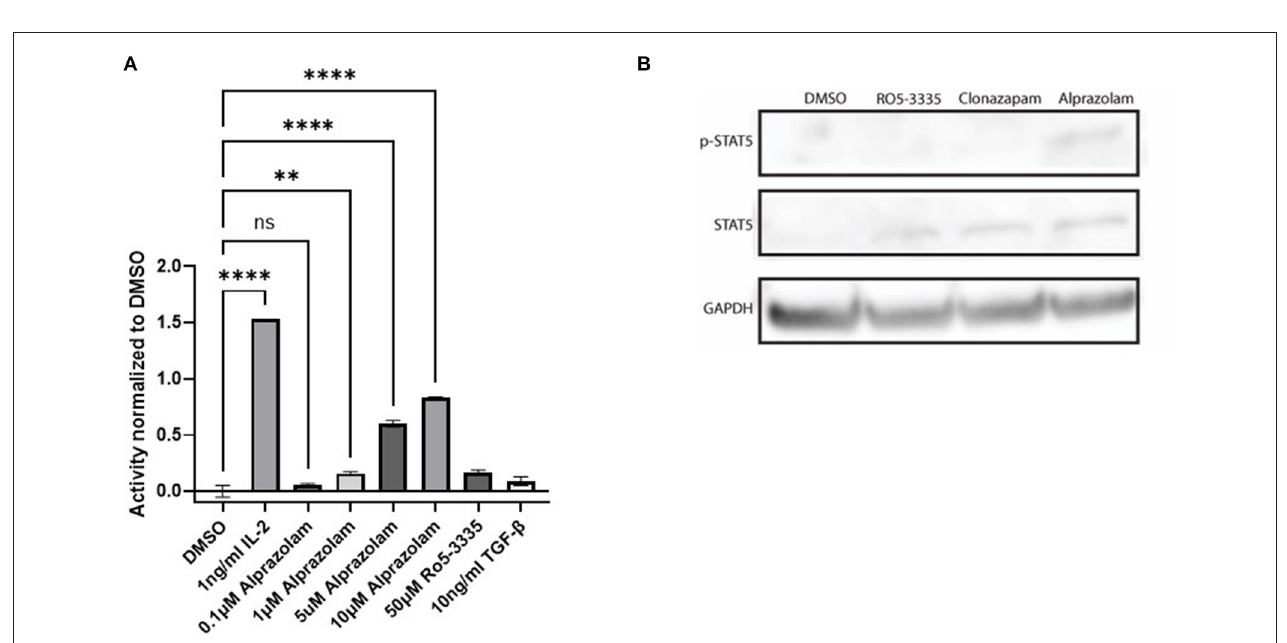
FIGURE 8 | Alprazolam activates a STAT5 sensitive reporter. HEK-Blue-IL2 cells were treated with indicated doses of IL-2, alprazolam or Ro5-3335 and incubated for 48h at 37C 5% CO2. (A) Extracellular alkaline phosphatase activity was then measured by colorimetric assay. Results show the average absorbance of three replicates. ** P ≤ 0.01, **** P ≤ 0.0001, ns = not significant (B) Western blot was performed to evaluate the effect of Benzodiazepines on STAT5 expression and